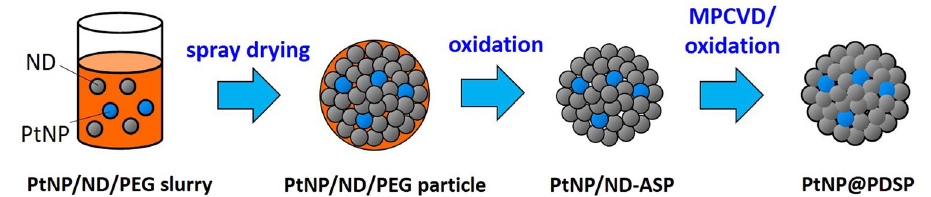
Figure 6. Schematic illustration for fabrication of